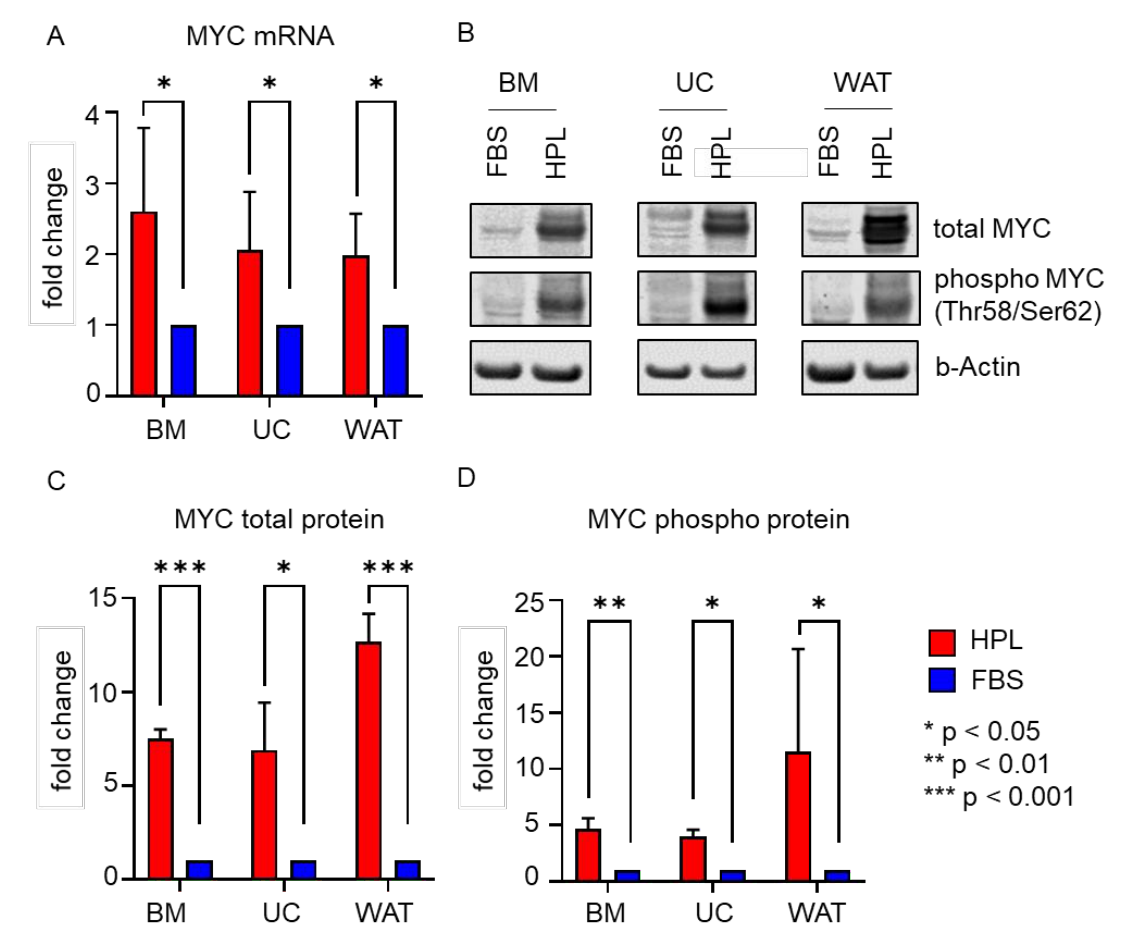
Figure 4. MYC mRNA and protein expression are significantly enhanced in HPL-cultured stromal cells. ( A ) RT-qPCR shows significantly enhanced MYC mRNA expression in HPL-culture (red bar) when compared to FBS (blue bar). Data shown are mean fold change values ± SD of three biological replicates measured in duplicates. ( B ) Western blot revealed significantly higher MYC total protein and phosphoprotein (Thr58/Ser62) expression in HPL-cultured stromal cells. One representative for each cell type is shown. ( C , D ) Quantitative analysis of Western blots depicted as mean fold change values ± SD of three biological replicates normalized to b(eta)-Actin expression (HPL: red bars, FBS: blue bars).